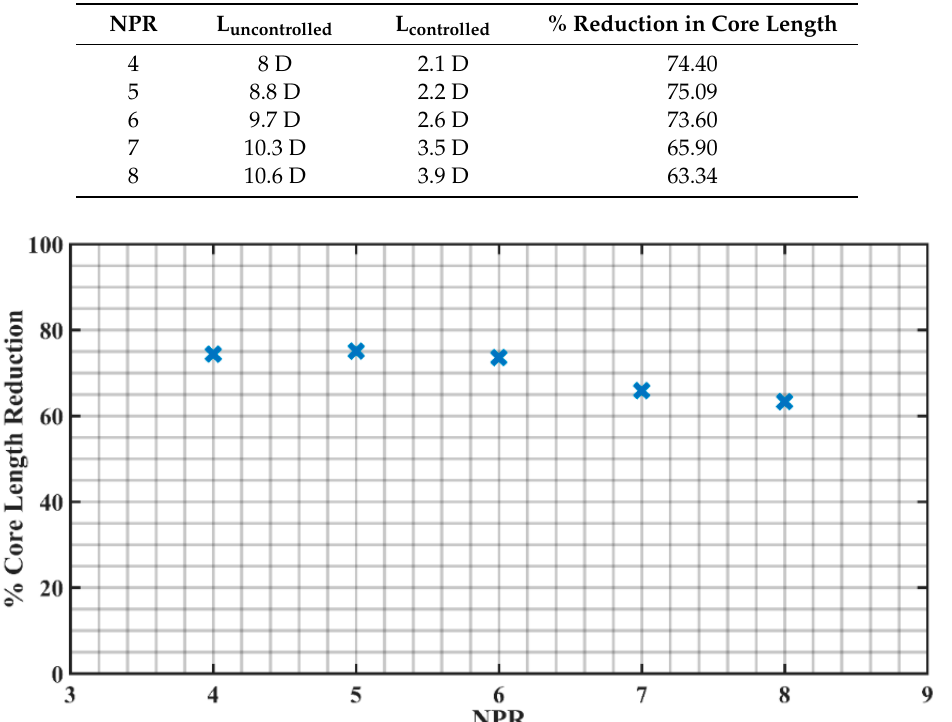
Figure 16. Fluctuation in percentage core length reduction with NPR.